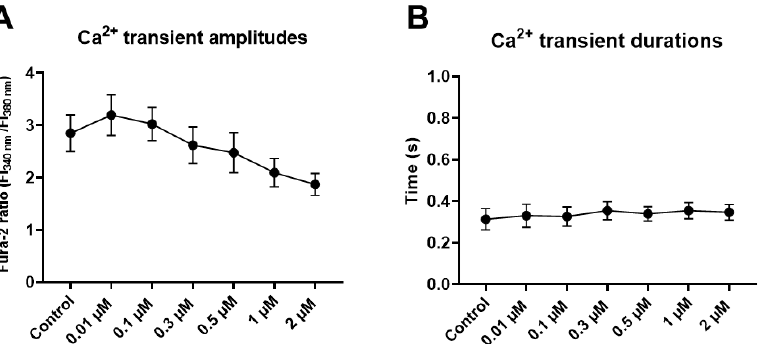
Figure 6. Danicamtiv did not alter intracellular Ca 2+ transients in canine cardiomyocytes. Ca 2+ transients were recorded in parallel with contractile parameters. No significant differences were observed in the Ca 2+ transient amplitudes ( A ) and durations ( B ) with danicamtiv.